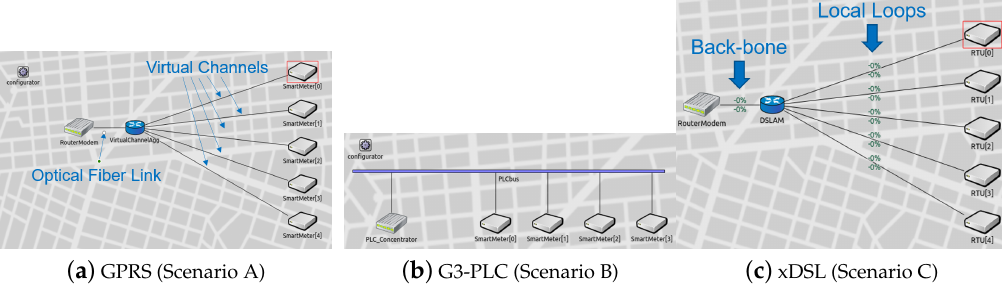
Figure 5. Implementation in OMNeT++ of the different topologies used in the scenarios to be simulated.